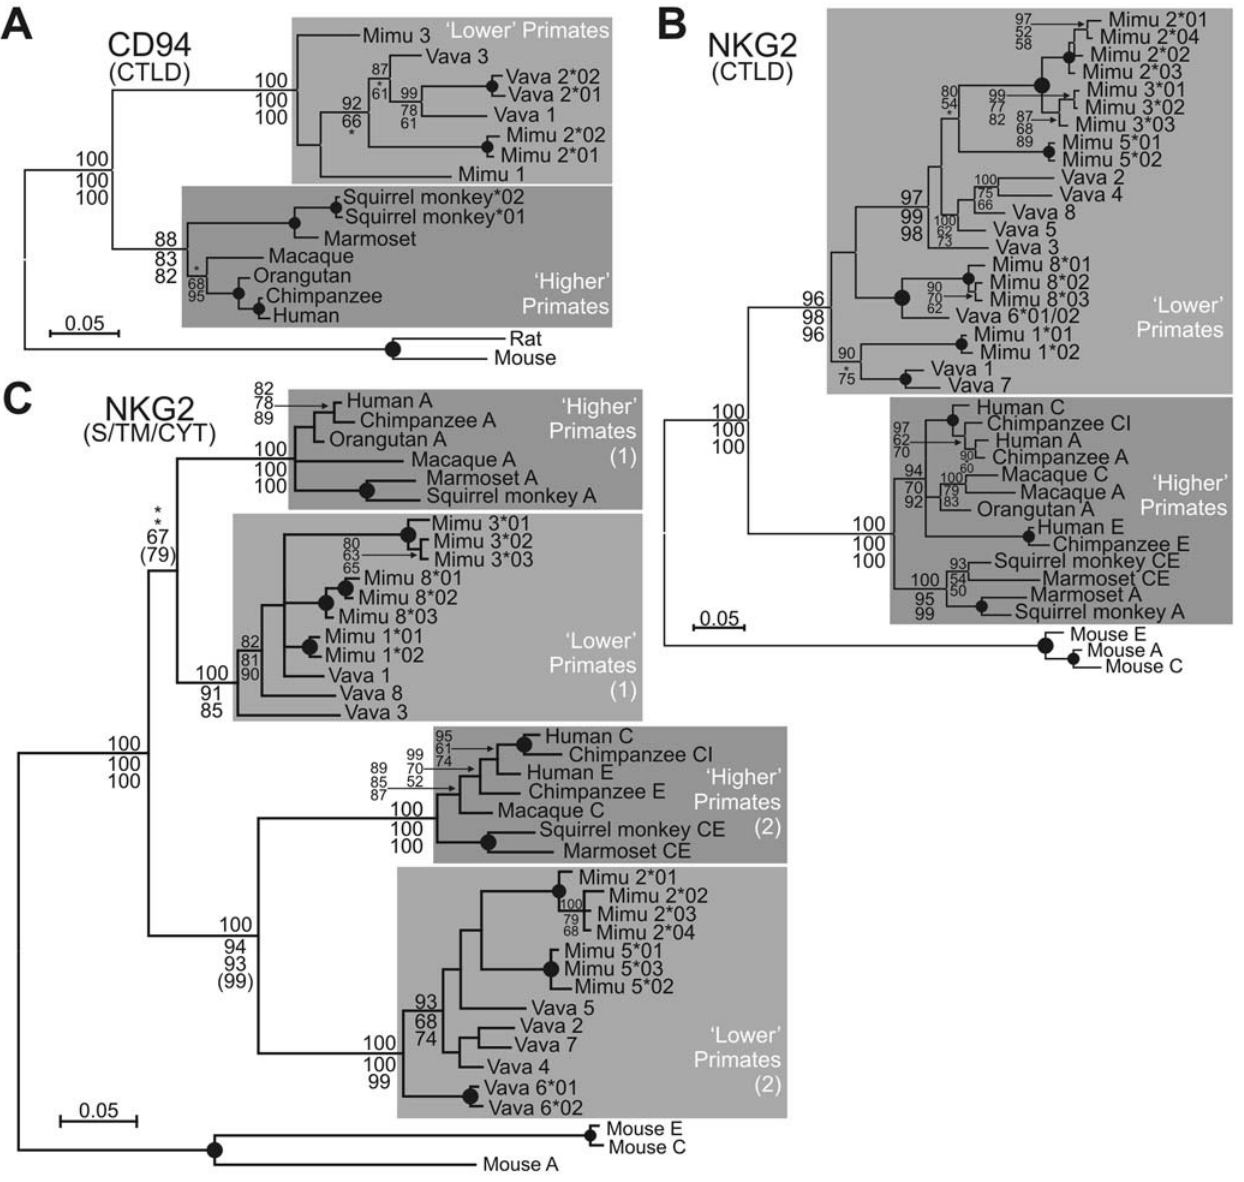
Figure 3. Major diversification of CD94 and NKG2 occurred in ‘‘lower’’ primates after their separation with ‘‘higher’’ primates. Phylogenetic analyses of primate CD94 (A) and NKG2 (B) C-type lectin-like domain sequences and NKG2 stalk, transmembrane, cytoplasmic regions (C). The tree topology obtained with the Neighbor-Joining (NJ) analysis was used for the display (with a midpoint rooting) and numbers at nodes indicate support obtained for Bayesian, parsimony, and NJ methods (from top to bottom). Support is shown if Bayesian posterior probability (PP) $ 88% and other methods bootstrap proportion (BP) $ 50% (at least 2 methods). Filled circles at nodes indicate PP . 95% and BP $ 80%. *: BP , 50 or PP , 80. Mimu,Microcebusmurinus; Vava,Varecia variegata. A maximum-likelihoodanalysis was also performed, andthe maximum-likelihoodbootstrap support is indicated in parenthesis for two nodes.